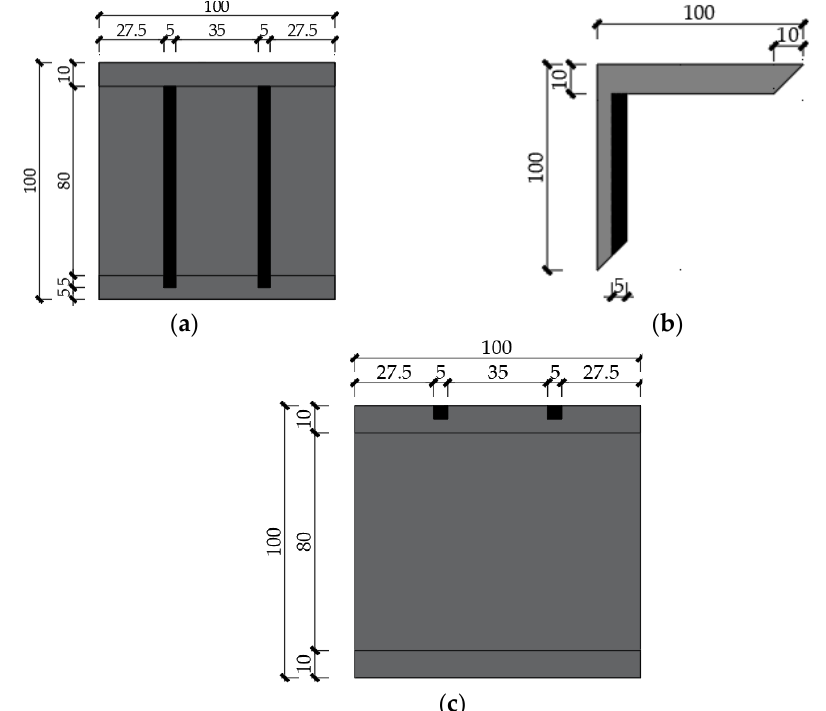
Figure 4. Geometric dimension and reinforcement distribution of the Z-connector: ( a ) front view; ( b ) side view; ( c ) top view (units: mm).